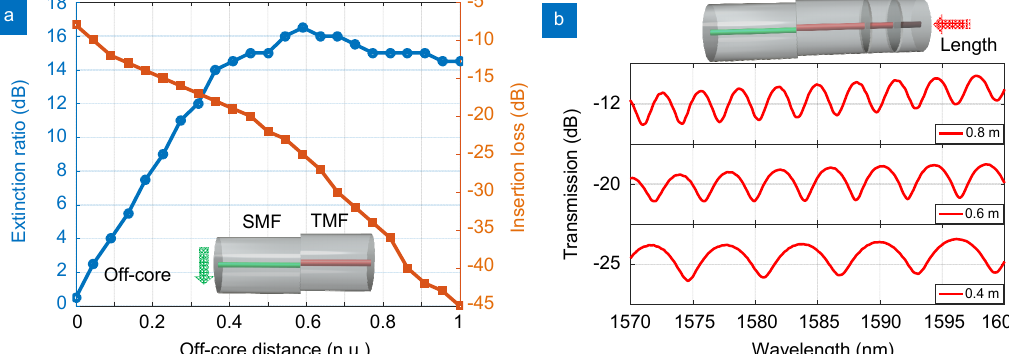
Fig. 4 | Summarized extinction ratio as well as insertion loss variation when the SMF shifts away from the TMF in transverse direction (a) and the spectra under different lengths of TMF from 0.8 m to 0.4 m (b).